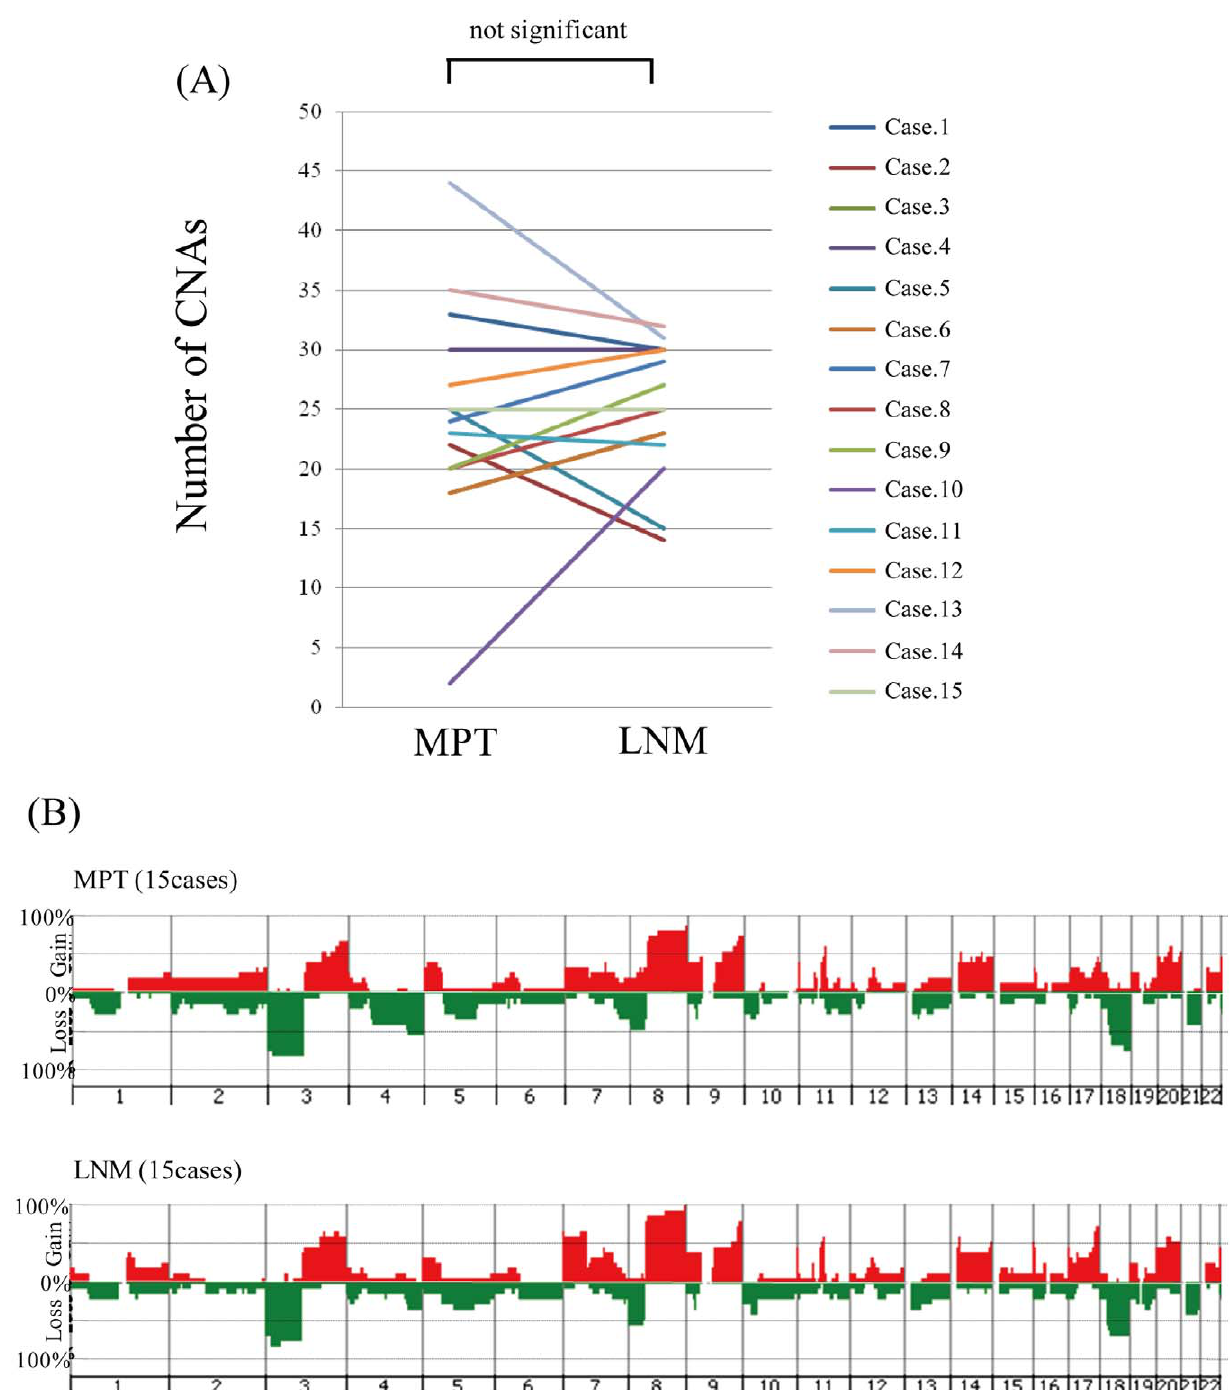
Figure 5. Comparison of CNAs between MPTs and the corresponding LNMs. (A) Comparison of the number of CNAs in the MPT and corresponding LNM in each case. (B) Genome-wide frequencies of CNAs in the MPTs and corresponding paired LNMs in the 15 cases. Horizontal lines: oligonucleotide probes are shown in order from chromosomes 1 to 22. Within each chromosome, clones are shown in order from the p telomere to the q telomere. Vertical lines: frequency (%) of gains (positive axis) and losses (negative axis) are shown for each probe.